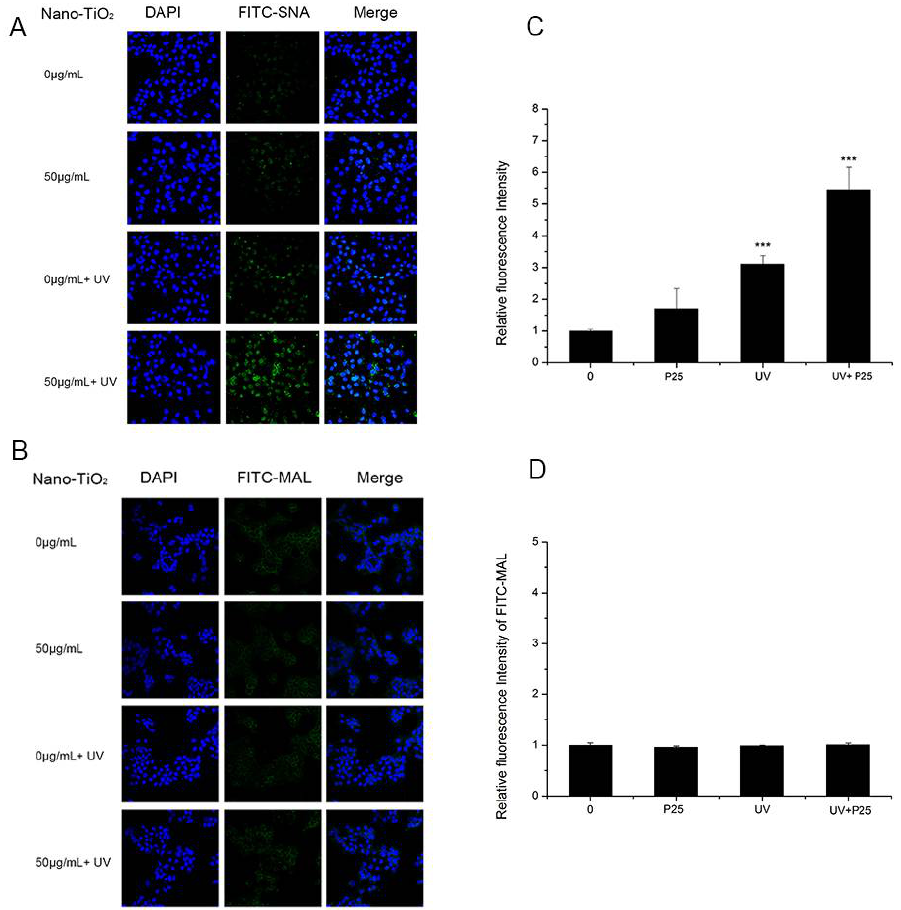
Figure 3. Assessment of changes in sialic acids by lectin staining. HaCaT cells were treated with 50 μg/mL nano-TiO 2 P25, UV or the combination of nano-TiO 2 P25 and UV. Staining was performed with fluoresceinIsothiocyanate (FITC)-labeled ( A ) SNA for α-2,6 sialic acid residues (green), ( B ) Maackia amurensis lectin (MAL) for α-2,3 sialic acid residues (green), and 4′,6-diamidino-2-phenylindole (DAPI) for nuclei (blue). The bar graphs show the fluorescent intensity analysis for ( C ) A and ( D ) B (*** p < 0.001, error bars are standard error of the mean).